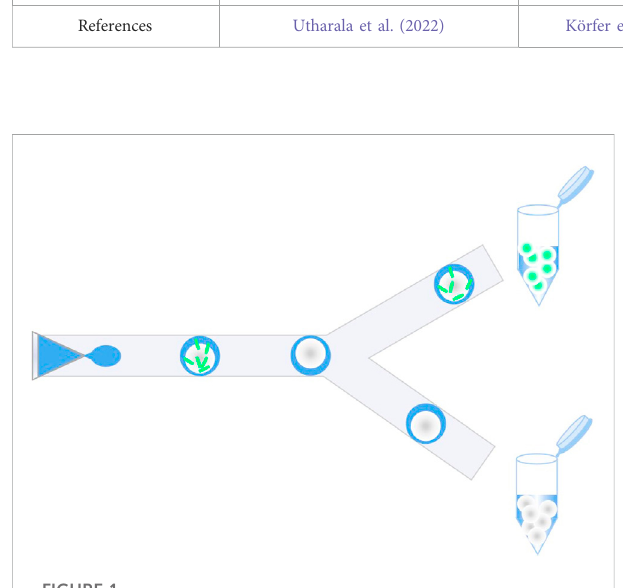
FIGURE 1 Schematic of high-throughput screening of microbial strains in micro fl uidic droplets, mainly including mutant library encapsulation and droplet